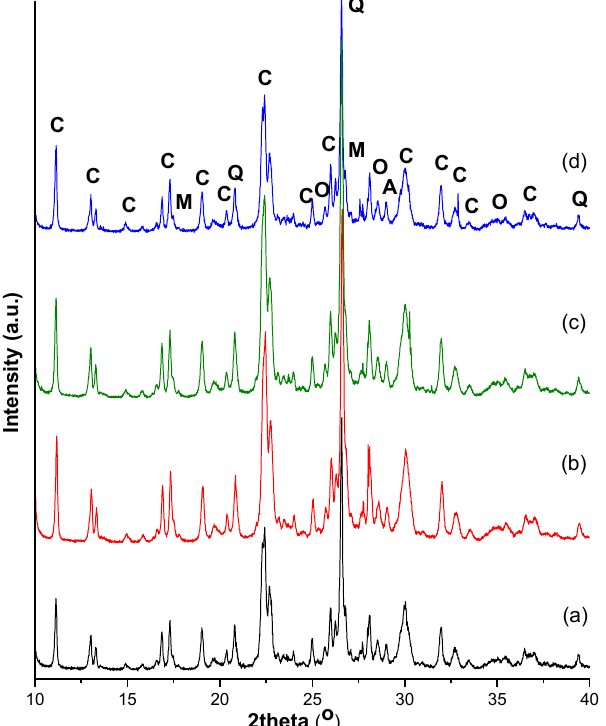
Figure 1. The XRD diffraction patterns of zeolite samples: ( a ) initial, ( b ) Cal 1, ( c ) HCl 1 and ( d ) NaOH 1 (Note: clinoptilolite, C; muscovite, M; quartz, Q; orthoclase, O and albite, A). In Figures 2–8, the images obtained from SEM for the surface structure of the zeolite are presented.